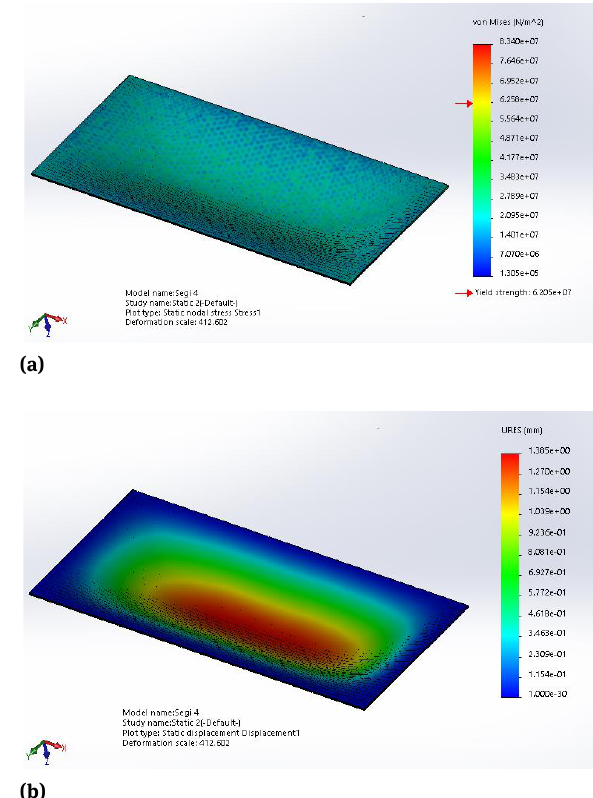
Figure 16: Results for the square honeycomb: (a) Von Mises stress and (b) resultant